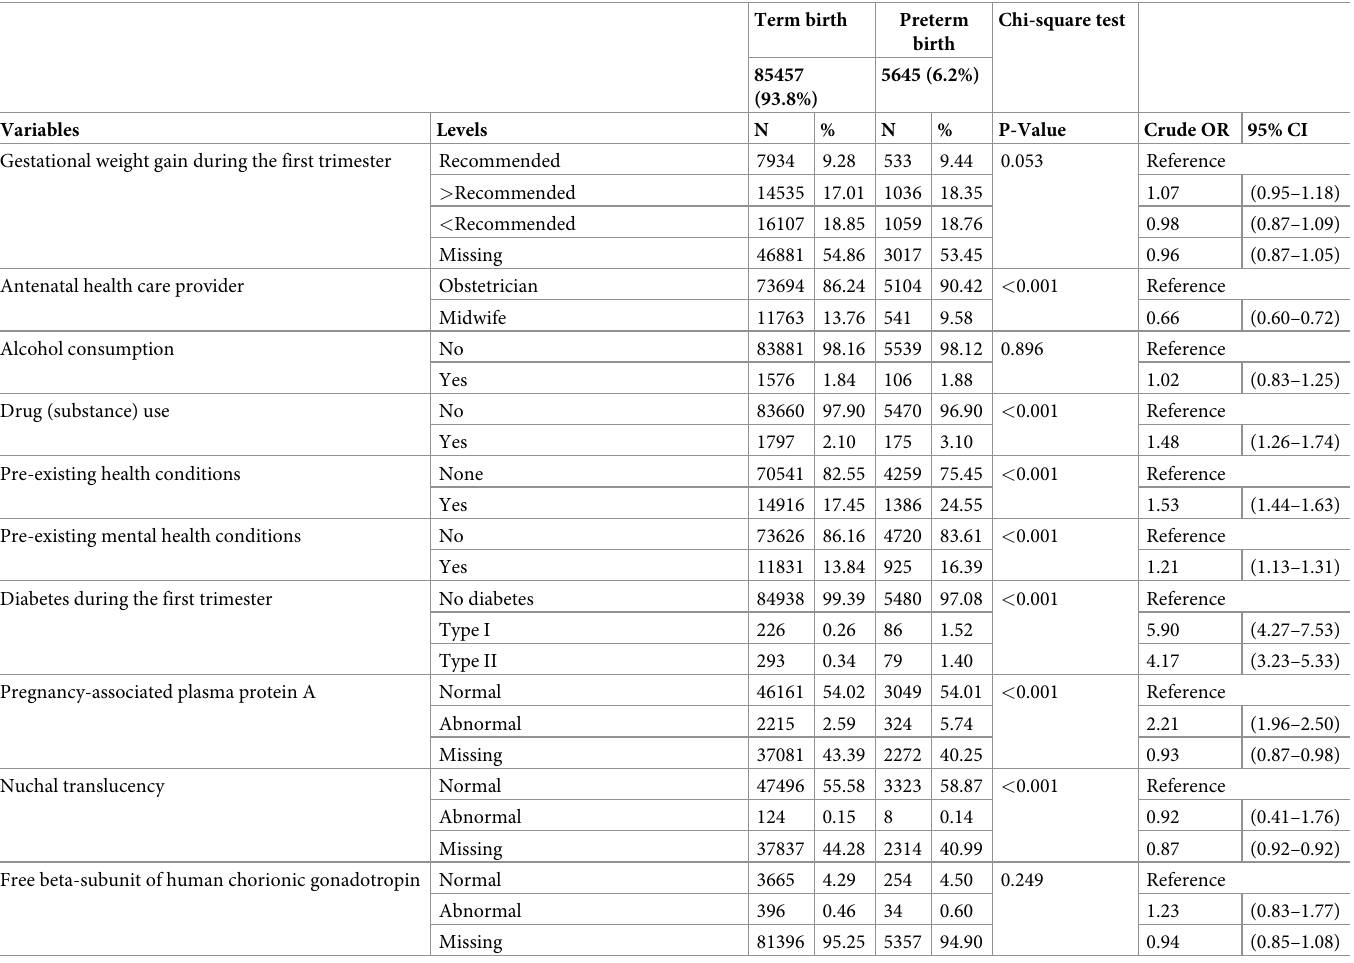
Multivariable analysis. Stepwise logistic regression identified 13 significant predictors during the first trimester (Fig 1). Diabetes (Type I: adjusted odds ratio (AOR): 4.21; 95%